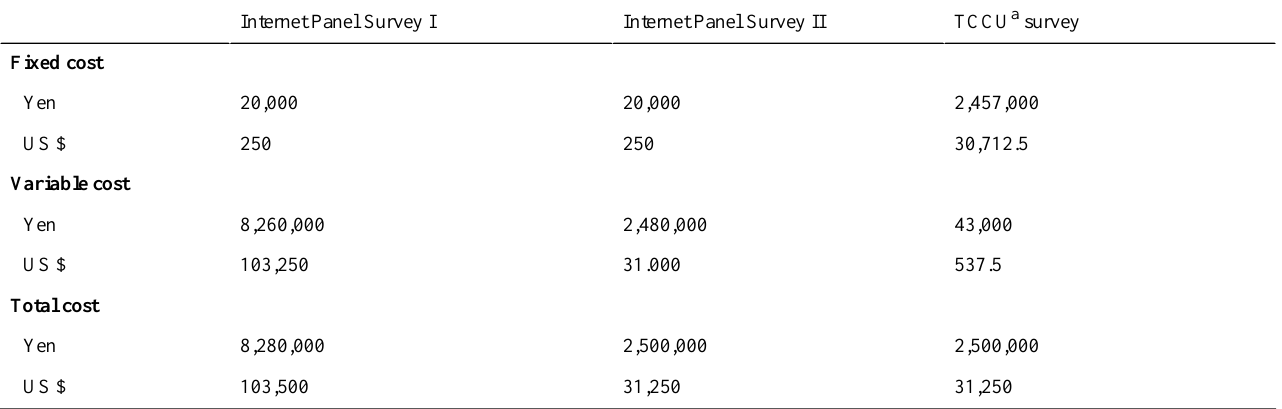
Table 3. Survey expenses for the three